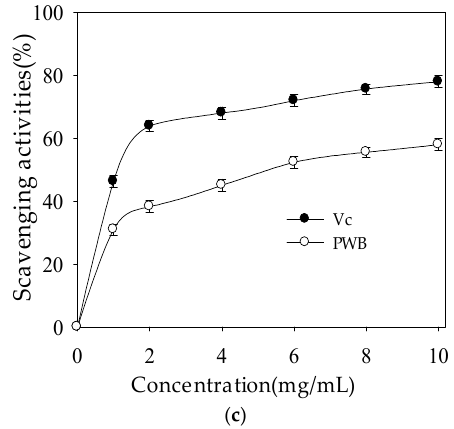
Figure 3. Scavenging activities of PWBs and ascorbic acid (V C ) with respect to the hydroxyl radicals ( a ); superoxide radicals ( b ); and DPPH radicals ( c ). All values are represented as mean ± standard deviation ( n = 3).